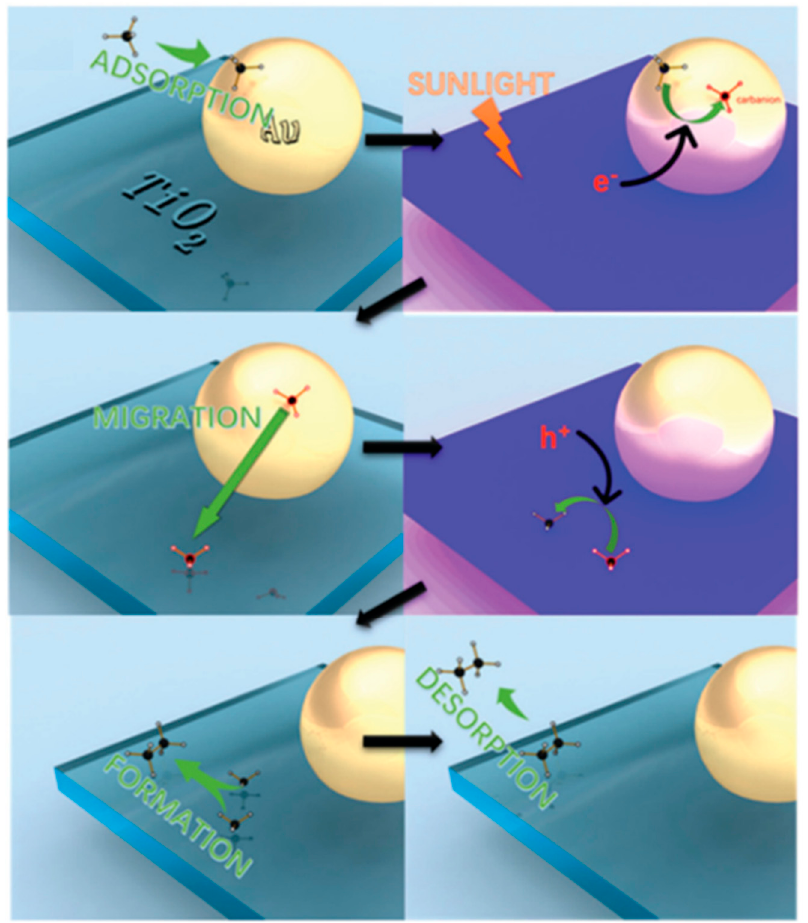
Figure 49. Mechanism of photocatalytic NOCM over Au/TiO 2 in a CH 3 − anion process. Reproduced from [28] with permission from The Royal Society of Chemistry.